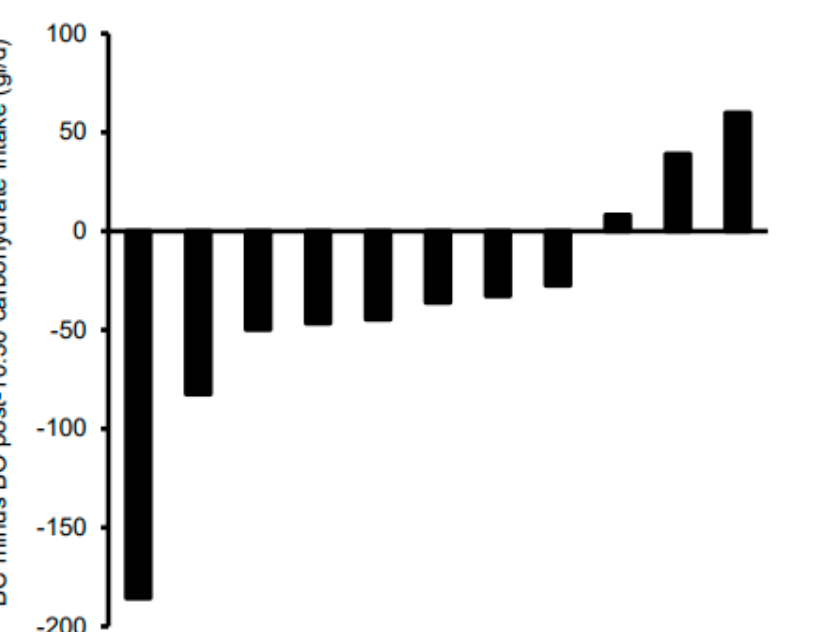
Figure 4. Individual post-10:30 carbohydrate intakes of adolescent girls who participated in the randomised crossover trial comparing seven days of breakfast consumption (BC) with seven days of breakfast omission (BO). BC was the consumption of a standardised breakfast with an energy content equivalent to 25% of individual resting metabolic rate before 09:00 for seven consecutive days; BO was the abstinence from all energy-providing nutrients until at least 10:30 for seven consecutive days.